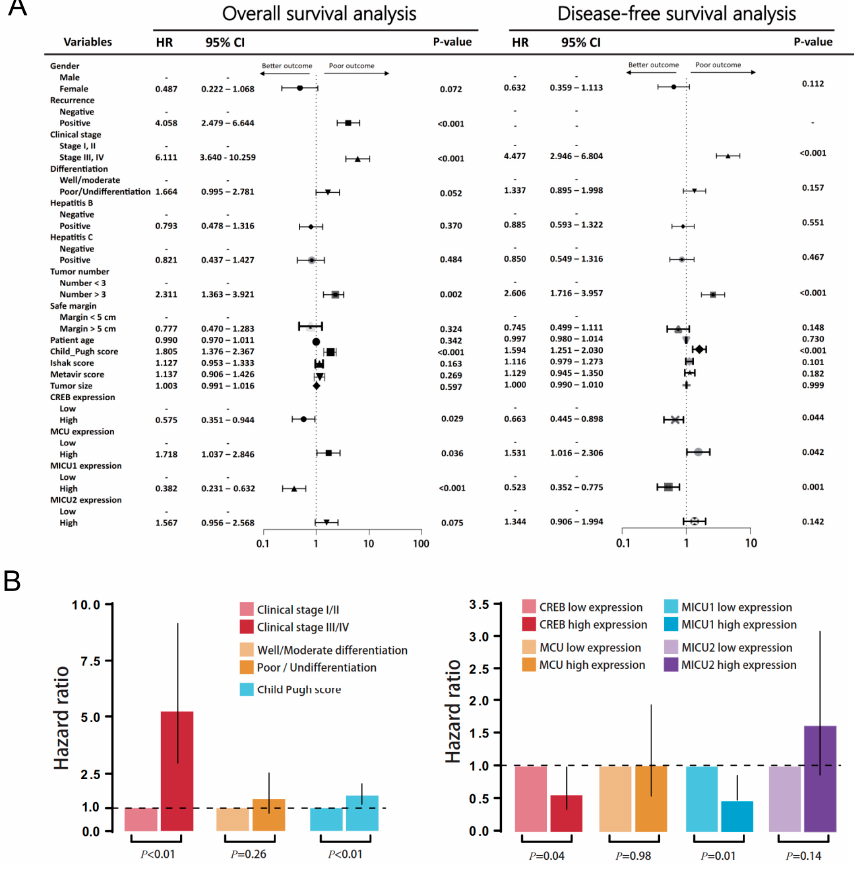
Figure 9. ( A ) Univariate analysis of influence of clinical characteristics in HCC patients. ( B ) Multivariate analysis of influence of clinical characteristics in HCC patients.